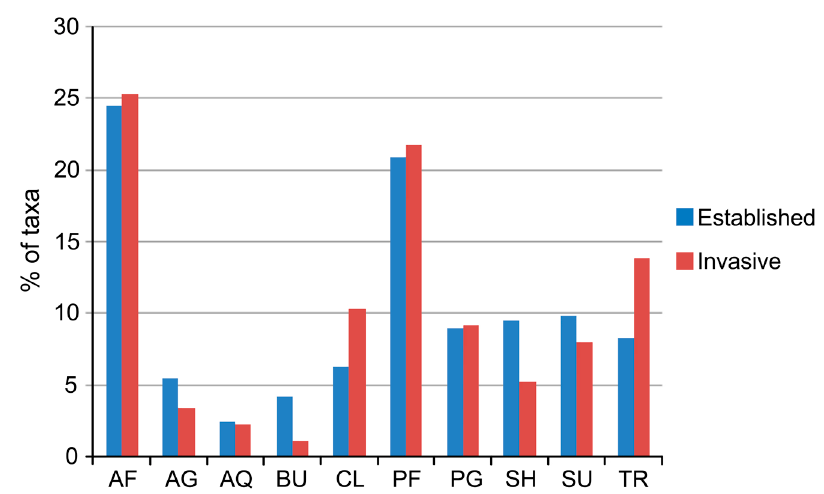
Figure 8. The percentage of taxa according to their plant growth type among the whole established aliens and among invasives. AF: annual forbs, AG: annual grasses, AQ: aquatic plants, BU: bulbous monocots, CL: climbers, PF: perennial forbs, PG: perennial grasses, SH: shrubs, SU: succulent plants, TR: